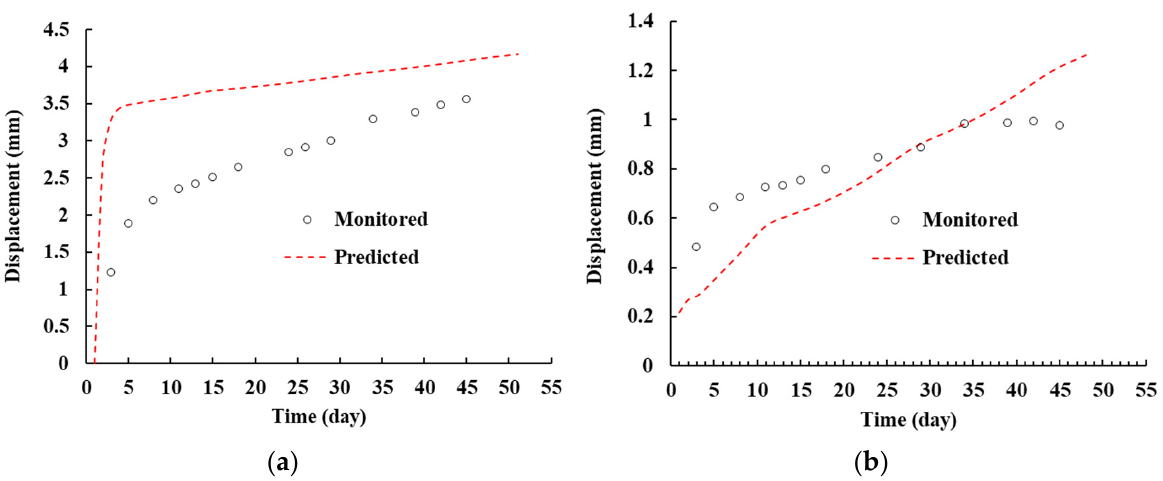
Figure 20. The displacement comparison between monitored data and values predicted by the numerical model based on obtained rheological parameters: ( a ) the monitored point at #4 borehole and ( b ) the monitored point at #6 borehole.